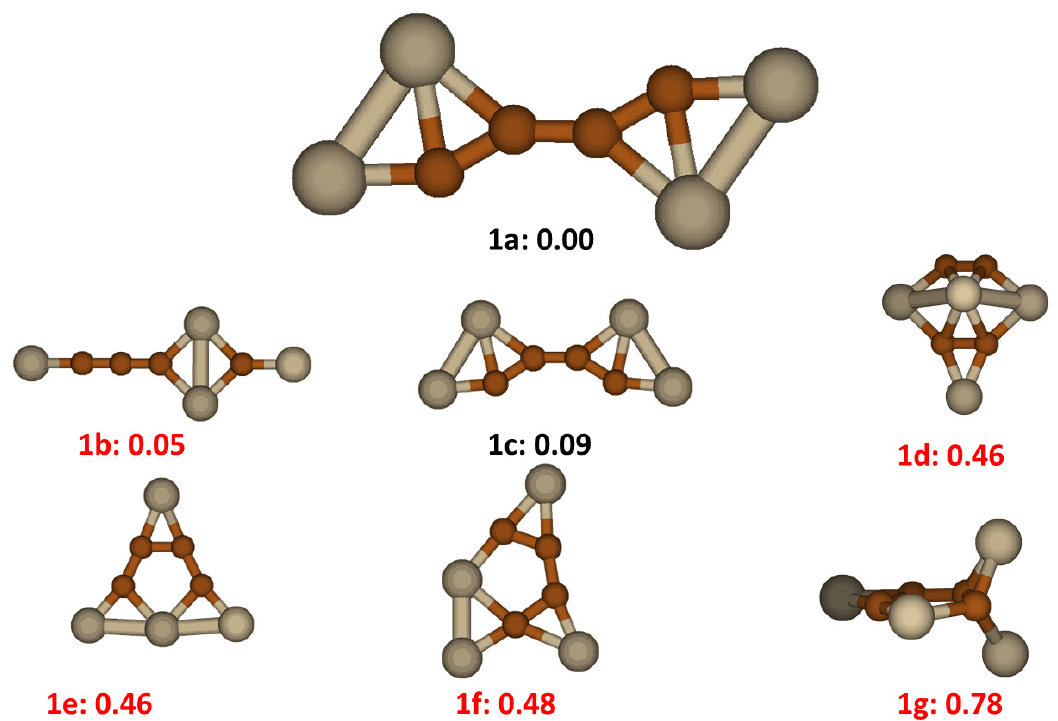
Figure 1. The structures and relative energies (in eV) of the lower energy Si Structures labeled in red have been previously reported in literature as 1b [13], 1d [14–16], 1e [17], 1f [17], 1g [18].